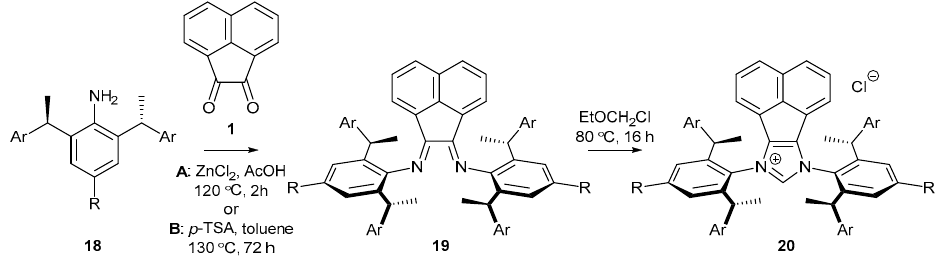
Scheme 6. Synthetic pathway to chiral C 2 -symmetric NHC precursor 20 . Table 1. Preparation of salts 20 .